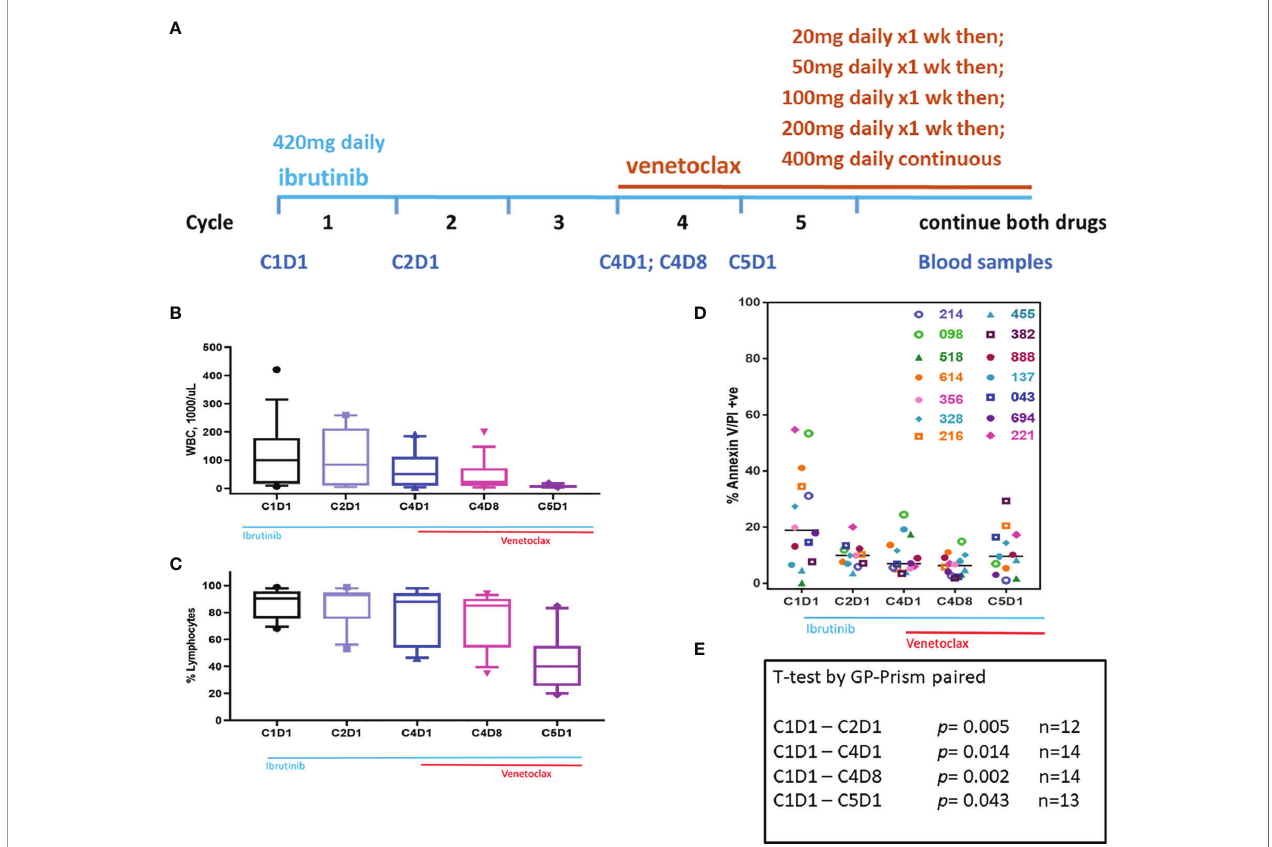
FIGURE 1 | Clinical trial and changes in WBC, % lymphocytes, and sensitivity of blood cells for endogenous cell death in culture. (A) Clinical trial started with 3 cycles of ibrutinib monotherapy followed by ibrutinib/venetoclax couplet. Ibrutinib started at 420 mg/d while venetoclax had a ramp up dosing as indicated. Peripheral blood samples were taken at C1D1, C2D1, C4D1, C4D8, and C5D1. (B) White blood cells (WBC) count at baseline and changes in WBC during therapy. Box plots and whiskers represent 10 – 90 percentile. (C) Lymphocyte % at baseline and at different time points during therapy. Box plots and whiskers represent 10 – 90 percentile. (D) PBMCs isolated from peripheral blood samples were incubated for 24 h with DMSO and cell death was determined using fl ow cytometry after Annexin V/propidium iodide (PI) staining. Each symbol represents a patient. All patients were previously untreated except patients 518 and 888 who received one or two prior therapies, respectively. Horizontal black bars represent median values. (E) P-values were determined for each time point from the data in panel (D) . Number of patient samples at each time is provided. C, cycle and D,